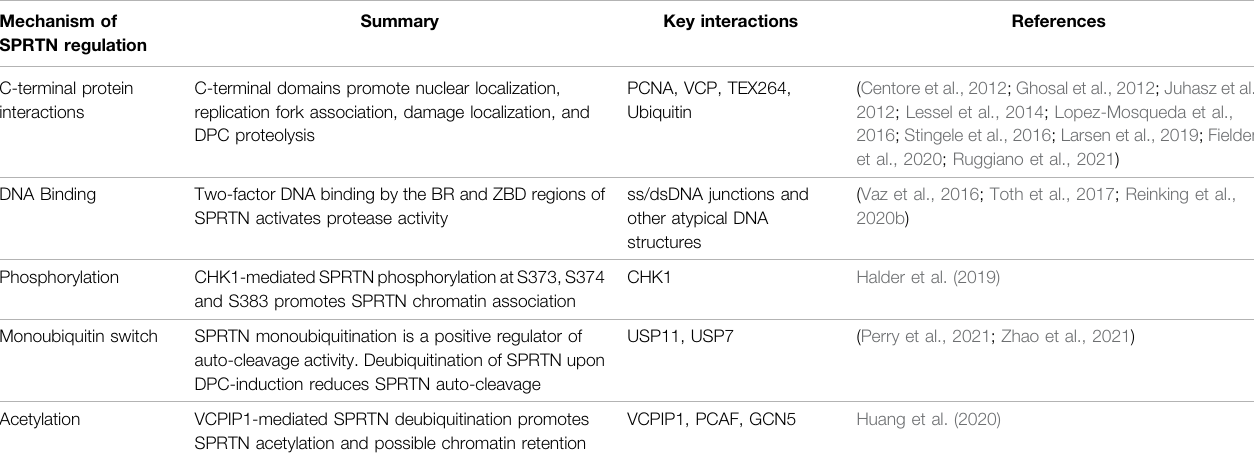
TABLE 1 | Mechanism of SPRTN regulation. Summary of mechanisms of SPRTN regulation, including a summary statement and relevant SPRTN posttranslational modi fi cations, protein-protein or protein-DNA interactions. See main text for expanded details. Key references are indicated in the right-most